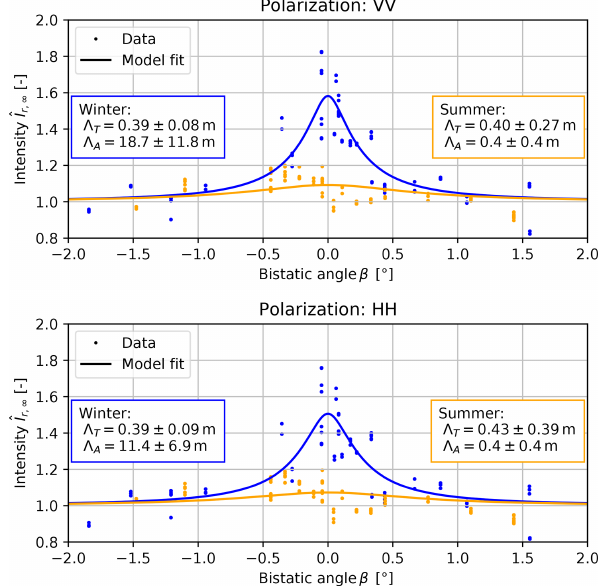
Figure 7. Intensity ratio ˆ I r , ∞ (β) observed during the ground-based experiment (KAPRI), showing backscatter enhancement in the win- ter dataset (blue). For the summer dataset (orange), the compara- ble values of the (cid:51) T and (cid:51) A estimates, as well as their relatively large confidence intervals, indicate that the CBOE peak was not detectable. The observed intensities ˆ I(β) were averaged over the whole region of interest for both polarizations, VV and HH. The blue and orange lines describe the least-squares fit model defined by Eqs. (6), (7), and (11) for winter and summer respectively. The colored boxes for each dataset show the best-fit value and the 95% confidence interval for the model parameters (cid:51) T and (cid:51) A describing the scattering and absorption mean free